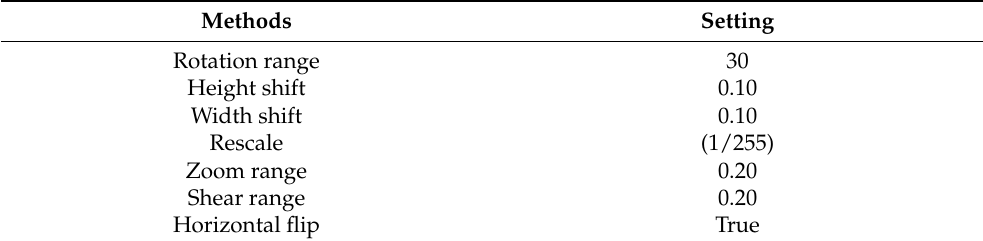
Table 1. The settings for the image augmentation